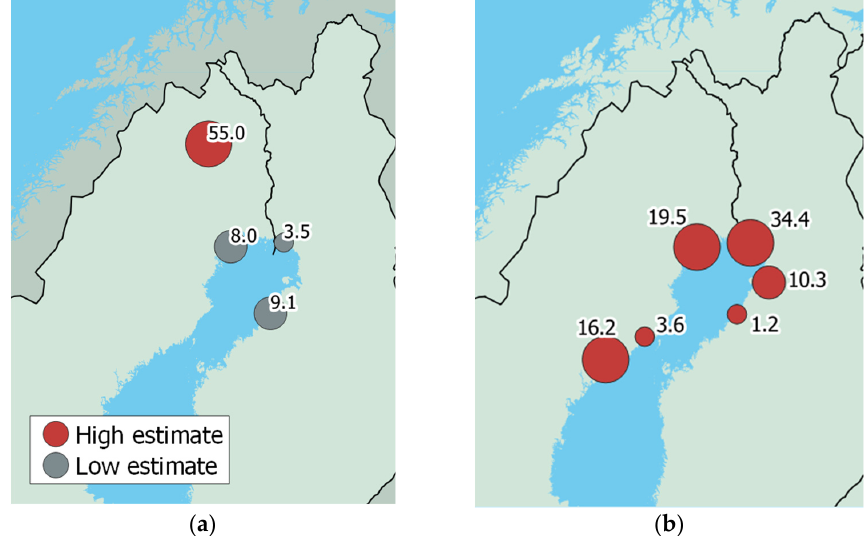
Figure 10. ( a ) Steel electricity demand (TWh); ( b ) Power-to-Methanol electricity demand (TWh) if all selected carbon sources were utilized.